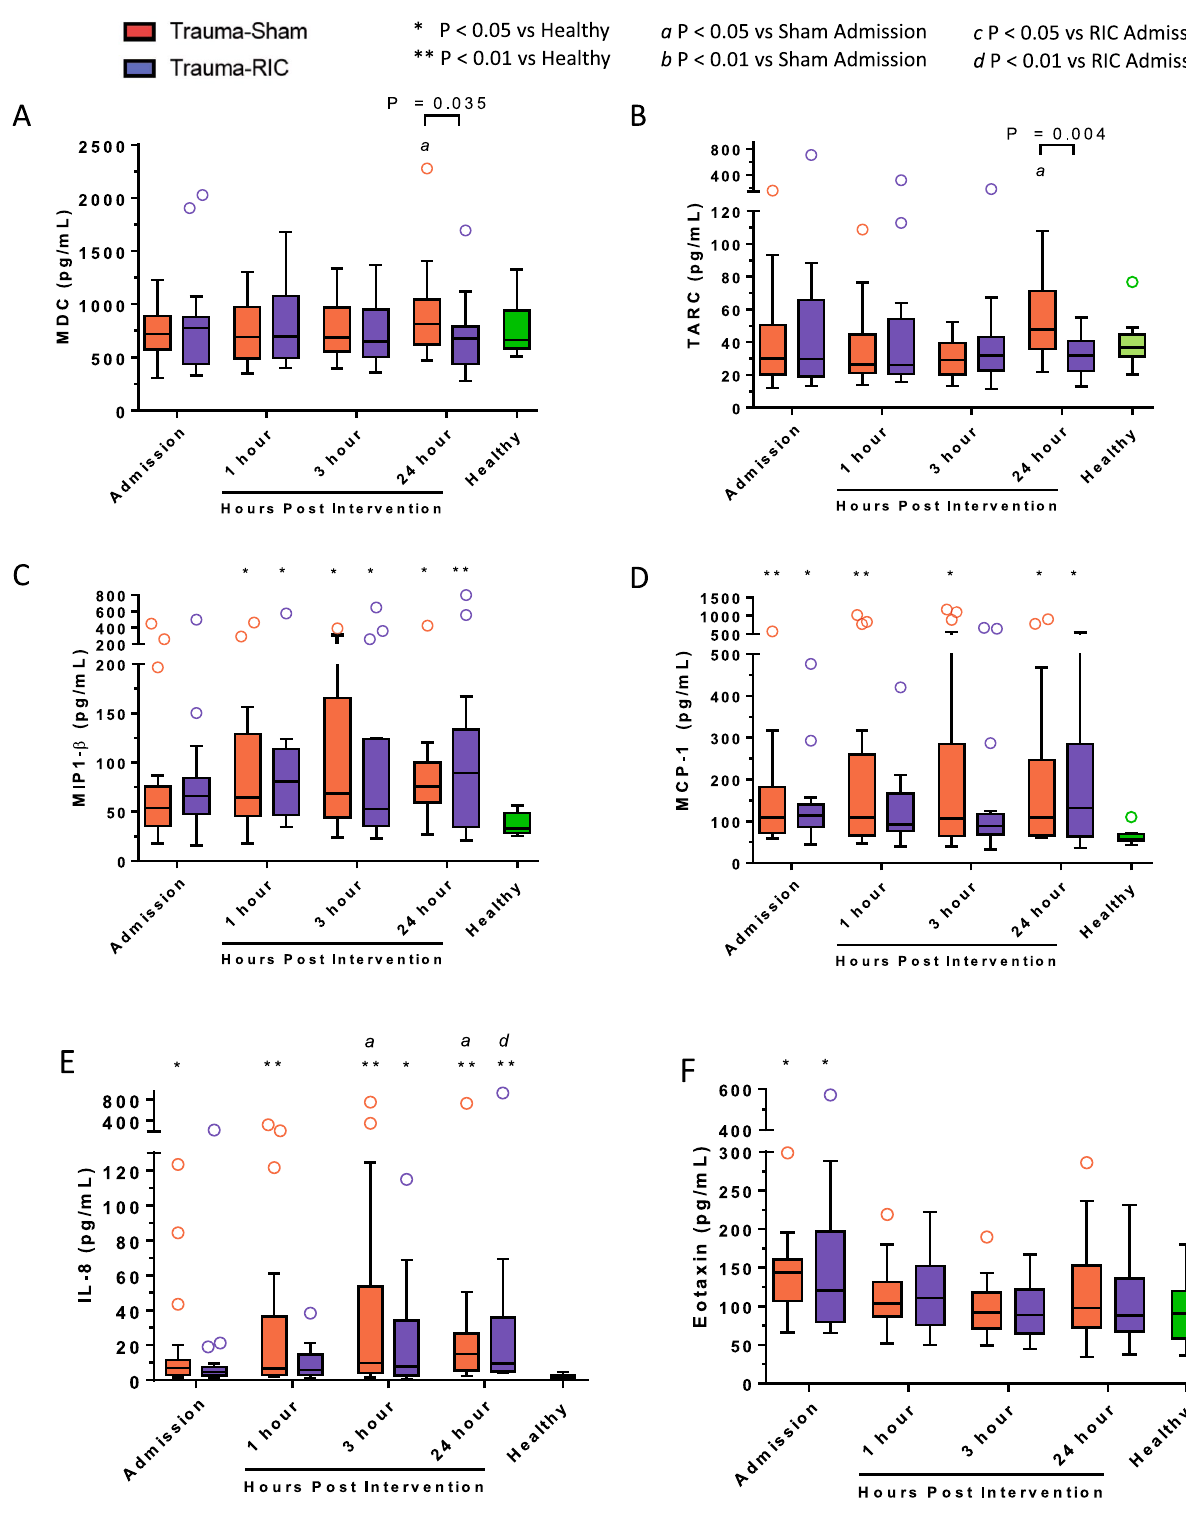
Figure 5. Plasma chemokine levels in trauma patients. ( A ) MDC, ( B ) TARC, ( C ) MCP-1β, ( D ) MCP-1, ( E ) IL-8, ( F ) Eotaxin. Red open circle = Trauma-Sham. Blue open circle = Trauma-RIC. Green open circle = Healthy Controls. Lines represent the median and interquartile range. a P < 0.05 vs Sham Admission. d P < 0.01 vs RIC Admission. *P < 0.05 vs Healthy Controls. **P < 0.01 vs Healthy